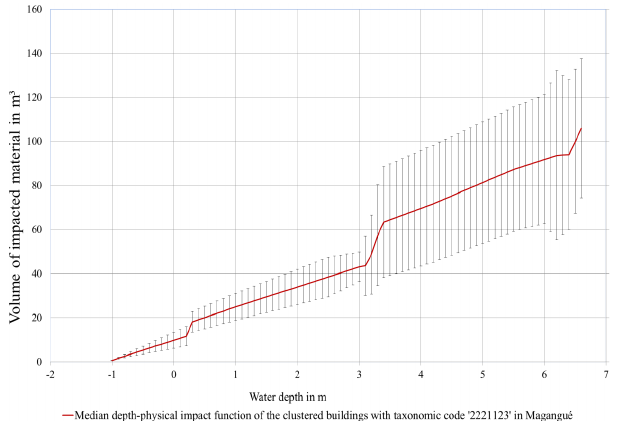
Figure 5. Depth–physical impact functions for the buildings A, B and C. Figure 6: Median and standard deviation of the Figure 5: Depth-physical impact functions for the buildings A, B and C